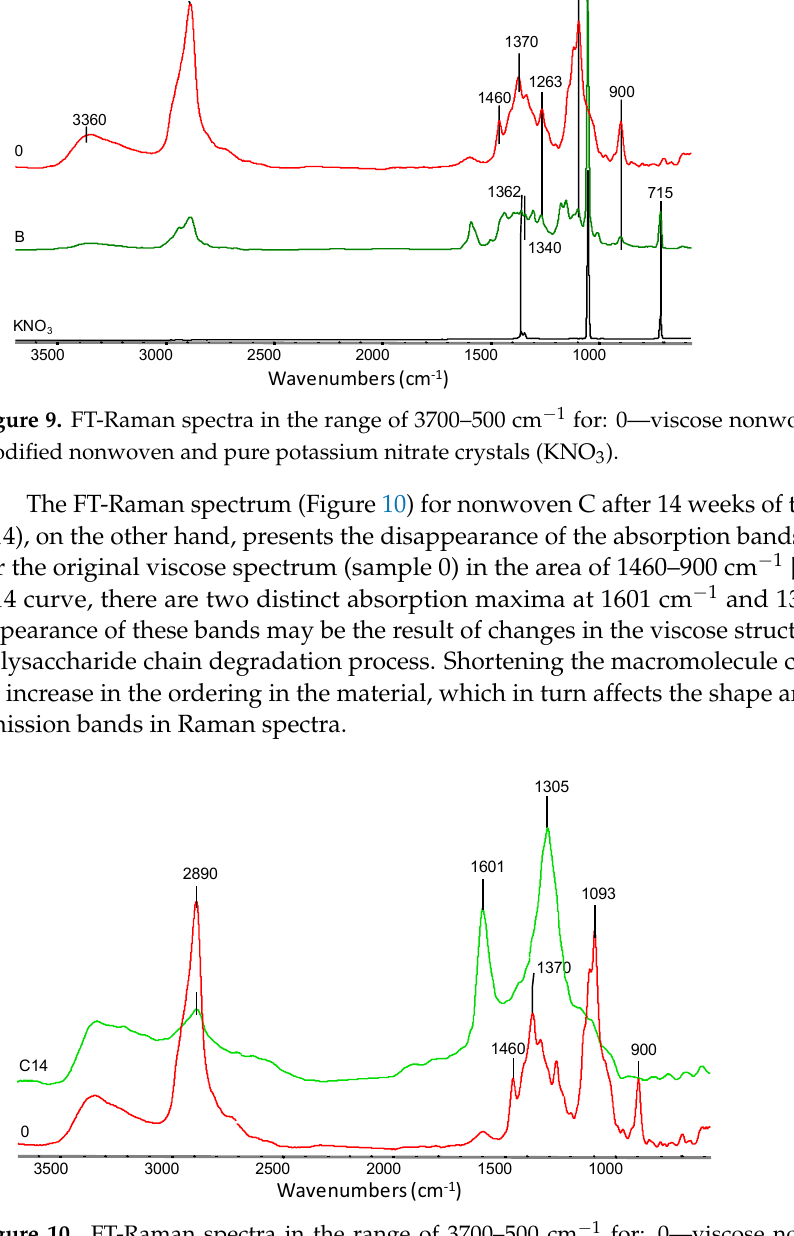
14 of 17 Figure 8. Summary of FTIR spectra for samples: 0—viscose nonwoven, B—KNO 3 modified nonwo- ven, C14—modified nonwoven C after 14 weeks of study, and KNO 3 salt spectrum at 4000–400 cm − 1 . On the FT-Raman spectrum (Figure 9) for a sample of nonwoven modified with